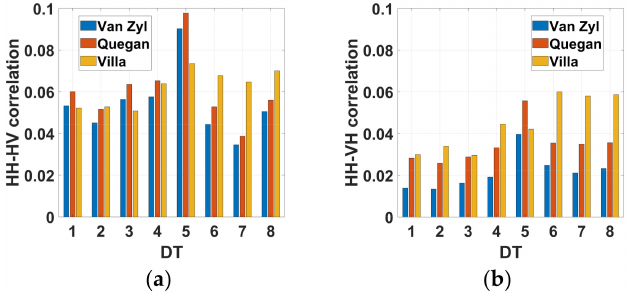
Figure 10. Correlation between ( a ) HH- and HV-polarization channels and ( b ) HH- and VH -polarization channels after polarimetric calibration is performed by each method over the selected DT.